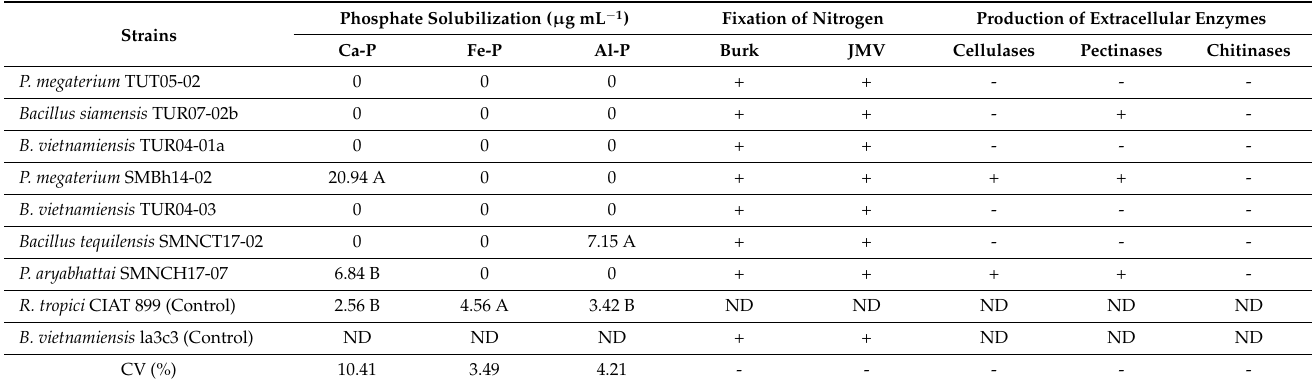
Table 3. Evaluation of plant-growth-promoting bacterial